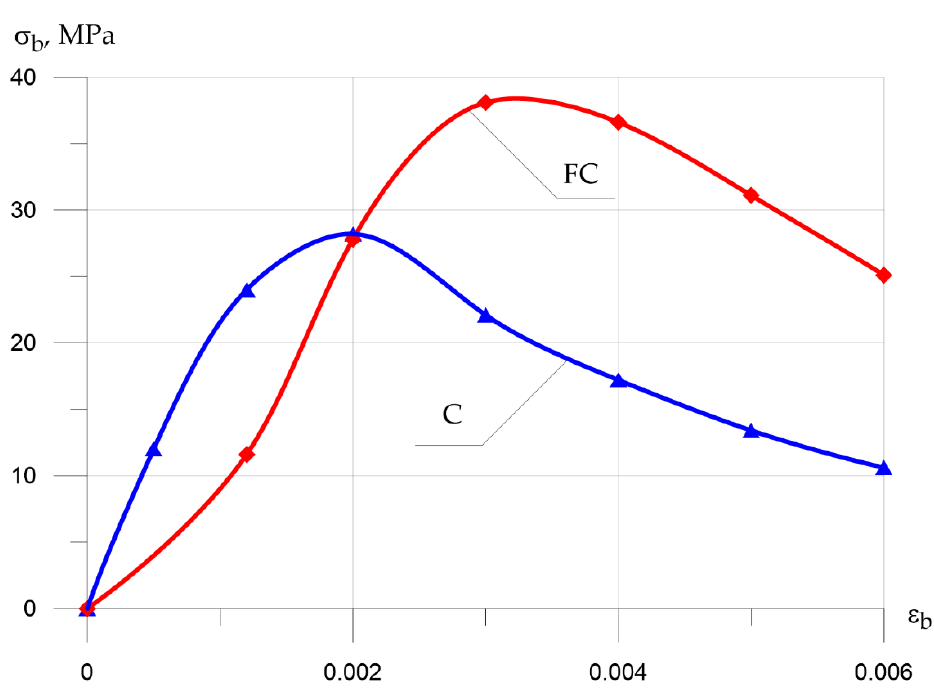
Figure 10. Stress – strain diagram for concrete compression (C, concrete; FC, fiber concrete). Figure 10. Stress–strain diagram for concrete compression (C, concrete; FC, fiber